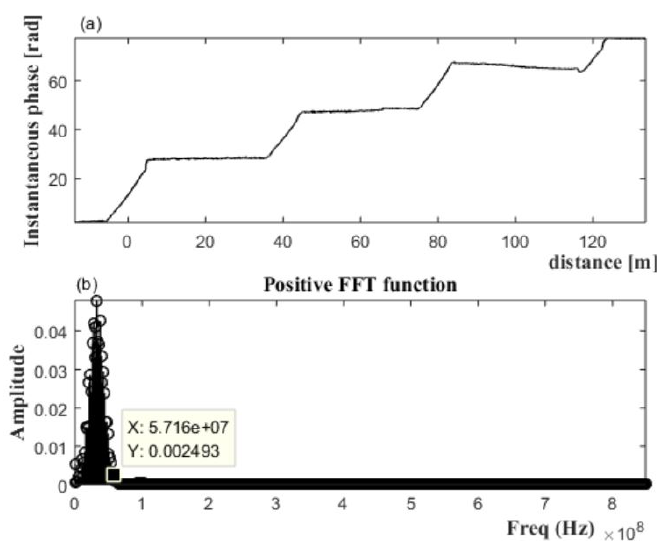
Figure 5. ( a ) Estimation of instantaneous phase, ( b ) frequency band of transmitted